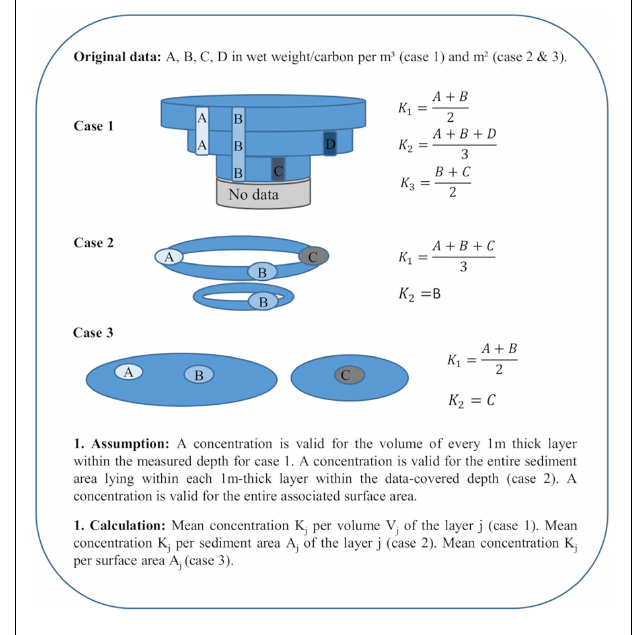
FIGURE 1 | Calculation of the mean concentration per layer, sediment or surface area ( K j ) for case 1, 2, and 3 pools. A, B, C, D, wet weight or carbon per m 3 /m 2 ; A j , sediment area within layer j or associated surface area; V j , volume of the layer j; and K j , mean concentration.